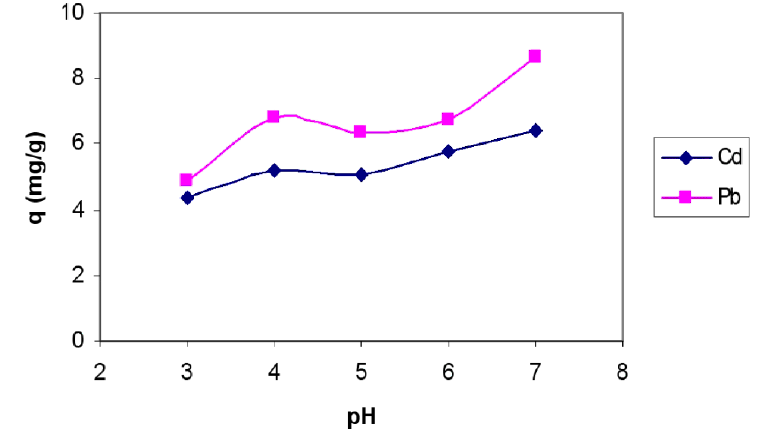
Fig. 6 In®uence of pH on the Pb and Cd biosorption at a initial Pb and Cd concentration of 10